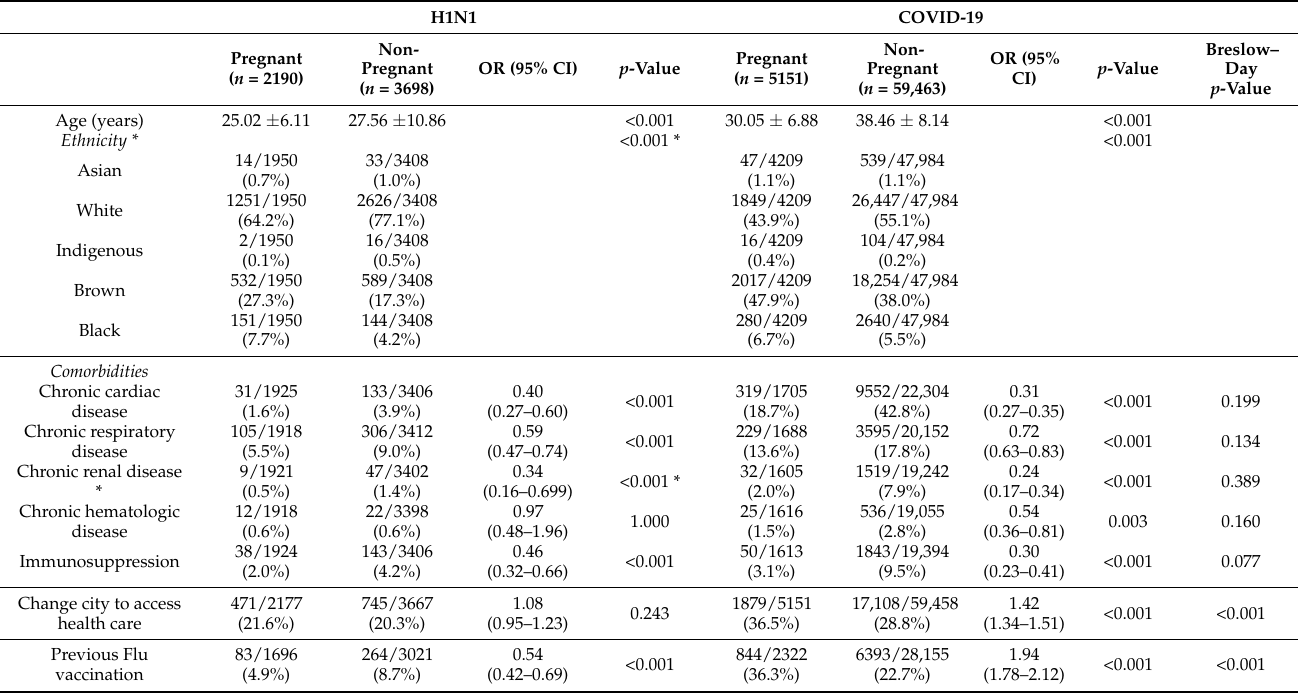
Table 1. Epidemiological and clinical characteristics of hospitalized women of childbearing age